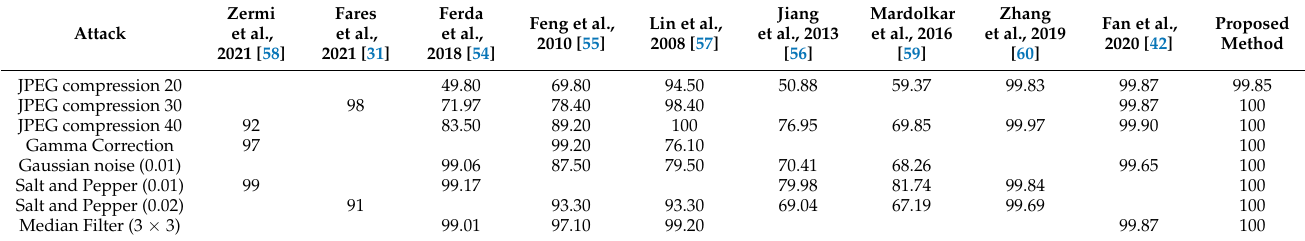
Table 10. Comparison of BCR (%) values of proposed with existing methods.